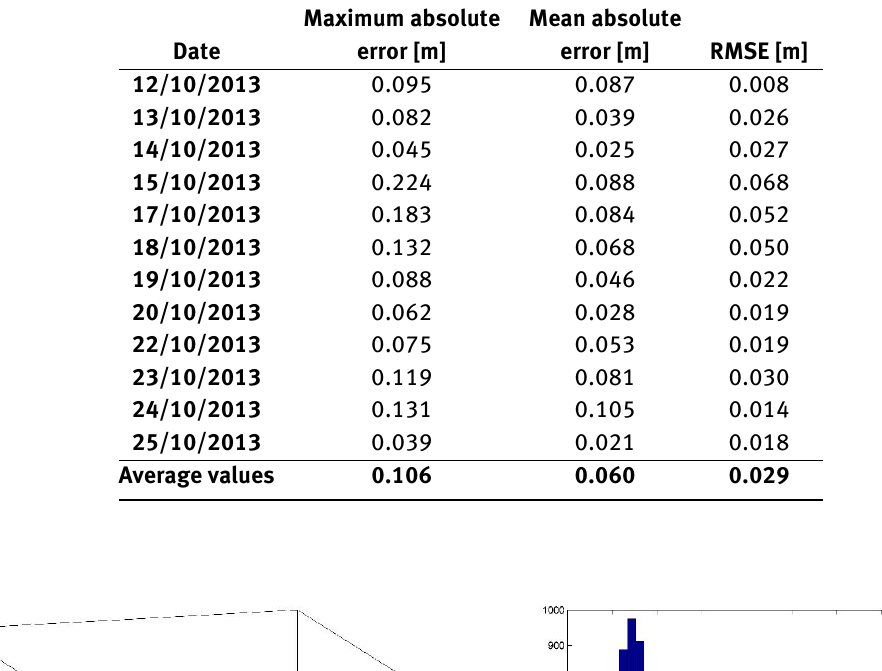
Table 1: Statistics summary of individual measuring days at the river.